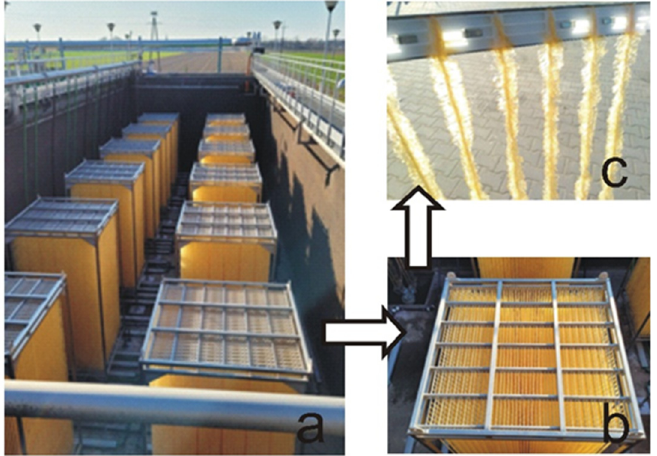
Figure 3. Cleartec BioCurlz biological bed modules (IFAS technology) attached to the activated sludge chambers ( a ); single module with biotextile for biofilm development ( b ); fragment of biotextile before installation—close-up ( c ).